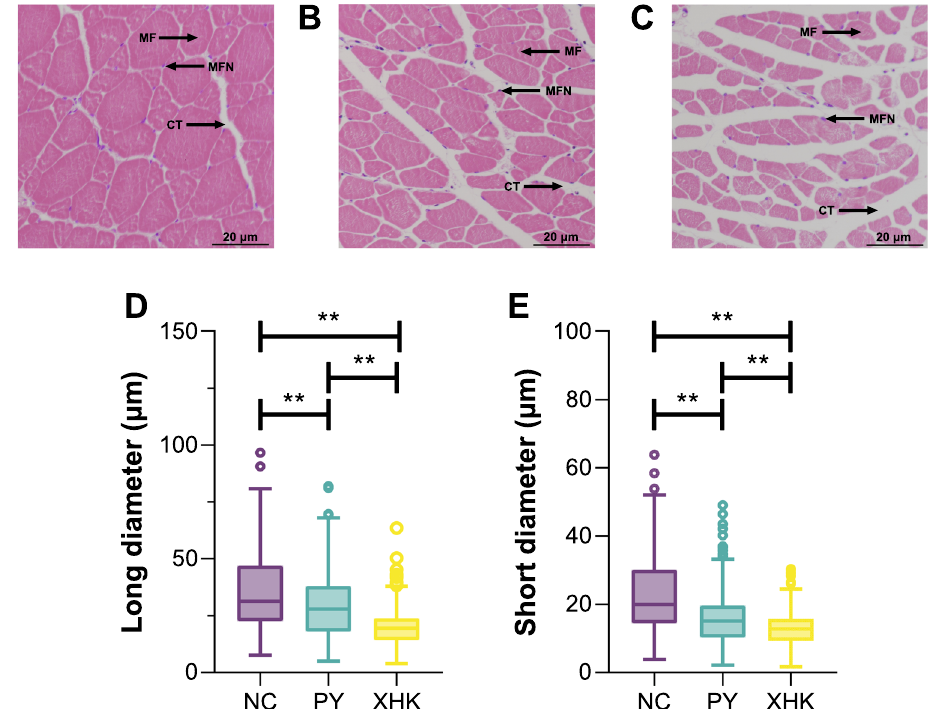
Fig. 1 Transections of muscle tissues and muscle fibres parameters of bighead carp from three groups. A NC diameter of muscle fibres; F short diameter of muscle fibres. (MF: muscle fibre; MFN: muscle fibre nucleus; CT: connective tissue). Significance levels with *, **, and *** represent FDR < 0.05, 0.01, and 0.001 between groups, respectively (Kruskal-Wallis